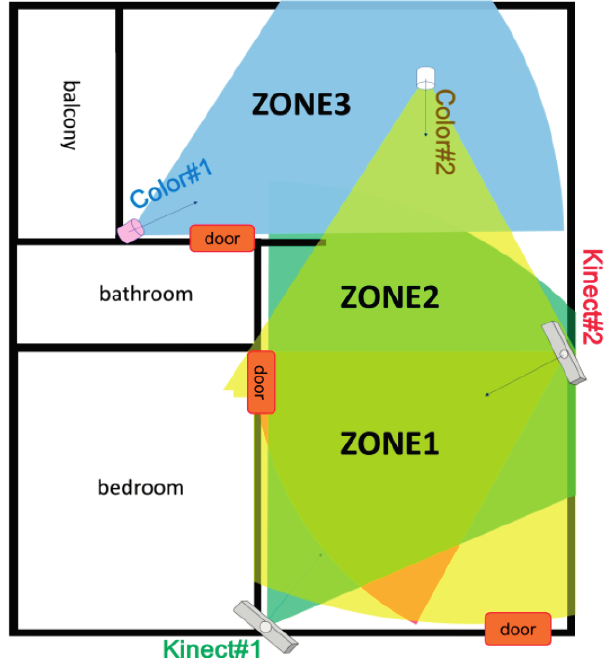
Figure 7. Typical layout of an elderly apartment. Two Kinects and two color cameras were installed to cover most open areas in the